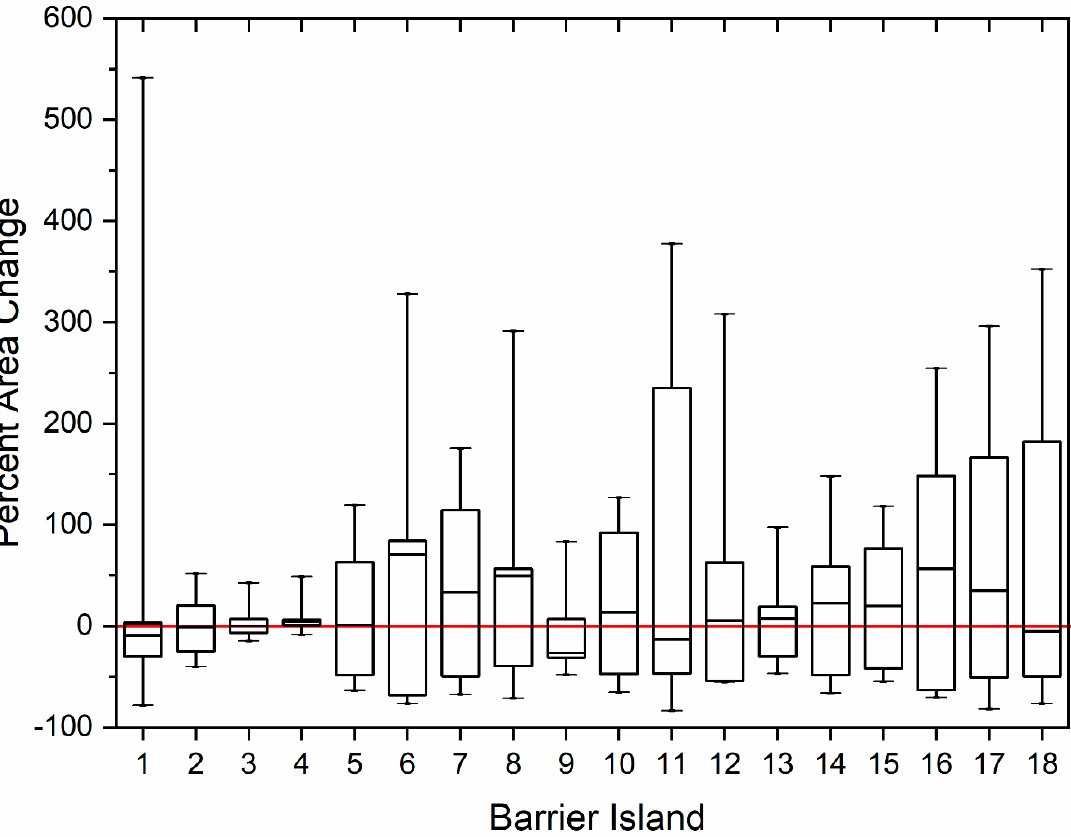
Figure 5. Barrier island percent area change from 1976 to 2017.